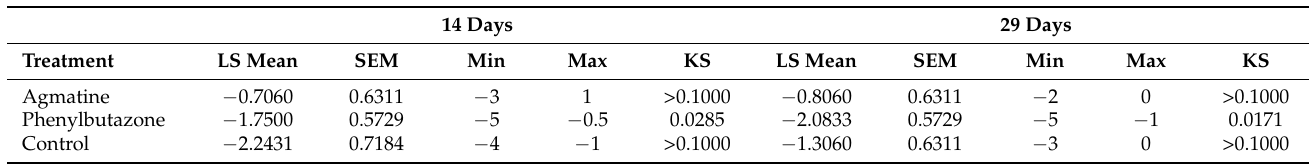
Table 4. Changes in subjective AAEP Lameness Score. Min: minimum; Max: maximum; KS: p -value of Kolmogorov–Smirnov test.